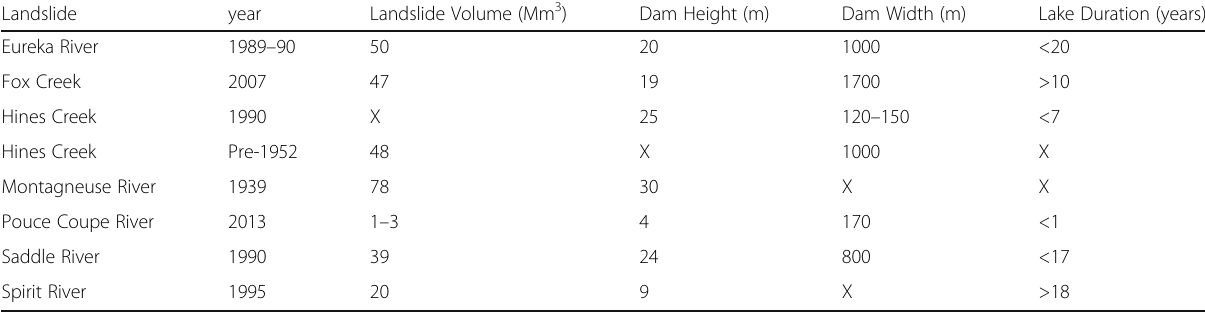
Table 1 Landslide and landslide dam